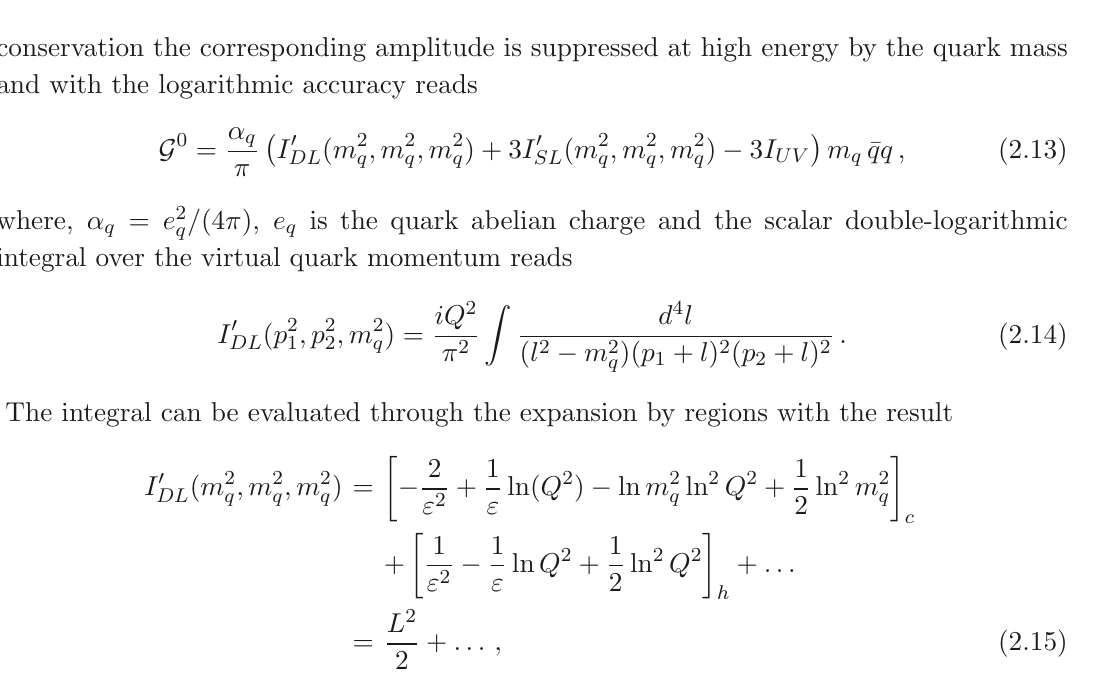
Figure 1 . The Feynman diagrams for (a) the leading order one-loop quark scattering by the ( G µν ) 2 vertex (black circle), (b) the soft gauge boson exchange with the effective vertices (gray circles) defined in the text which represents the non-Sudakov double-logarithmic corrections, (c) the renormalization group running of the effective coupling constant in